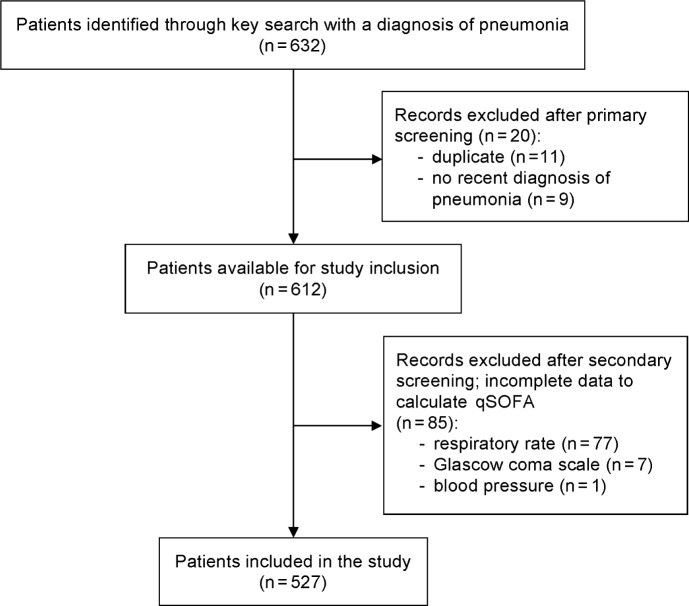
CONSORT flow chart.